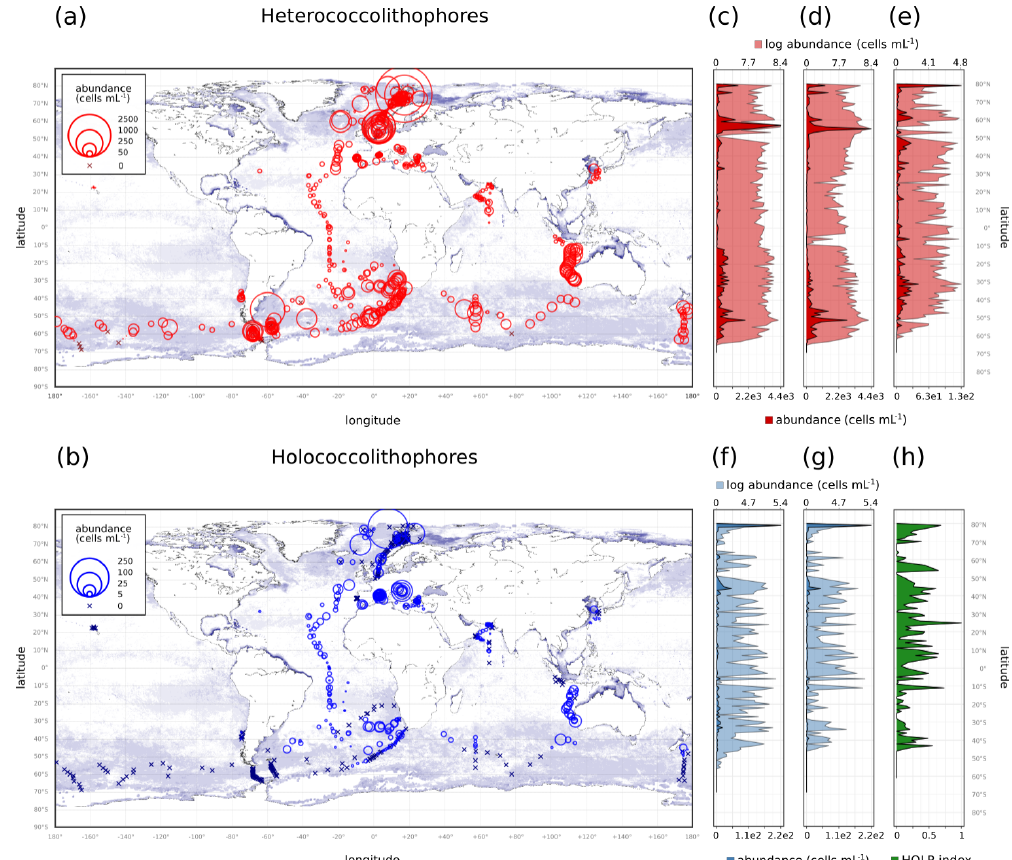
Figure 4. (a–b) Global coccolithophore distribution and (c–h) latitudinal coccolithophore distribution: (a) Heterococcolithophores, (b) Holo- coccolithophores, (c) Heterococcolithophores, (d) E. huxleyi , (e) paired heterococcolithophores, (f) holococcolithophores, (g) paired holo- coccolithophores, and (h) HOLP index. For the latitudinal plots, the light shading is log-transformed distribution.